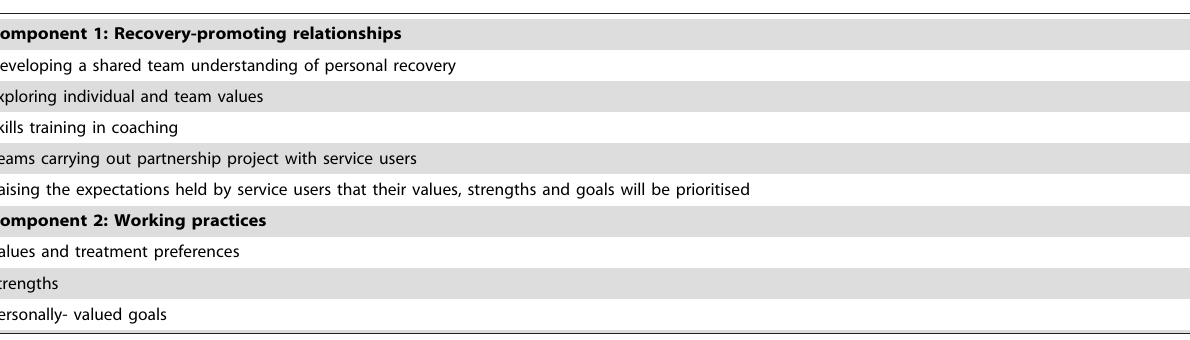
Table 1. Summary of REFOCUS intervention